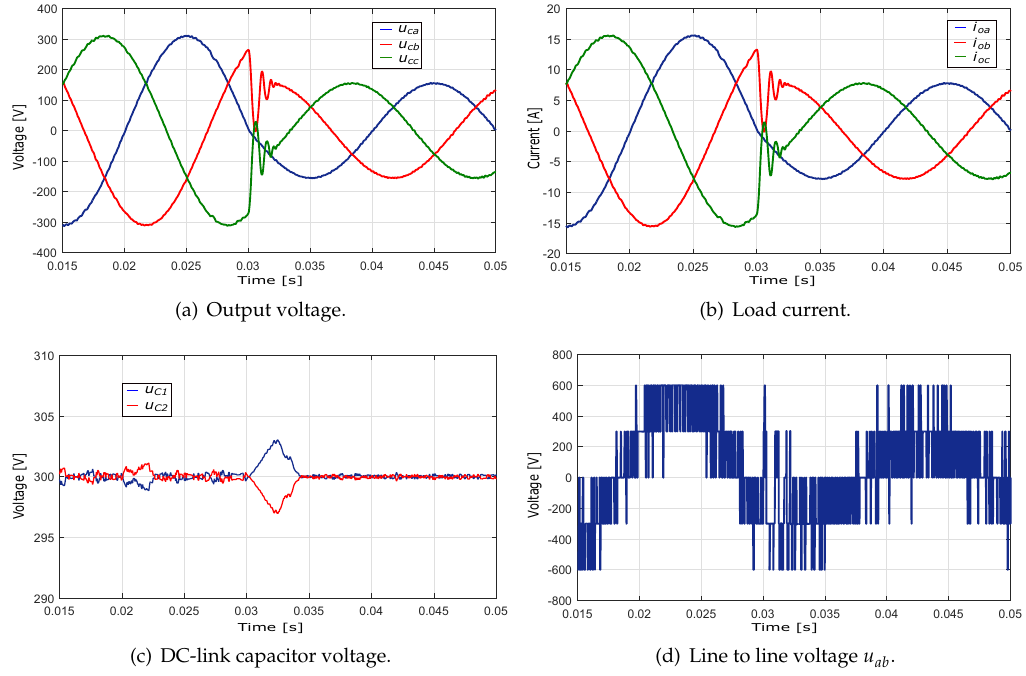
Figure 7. The dynamic response of the proposed method for step change from 311 to 155 V.